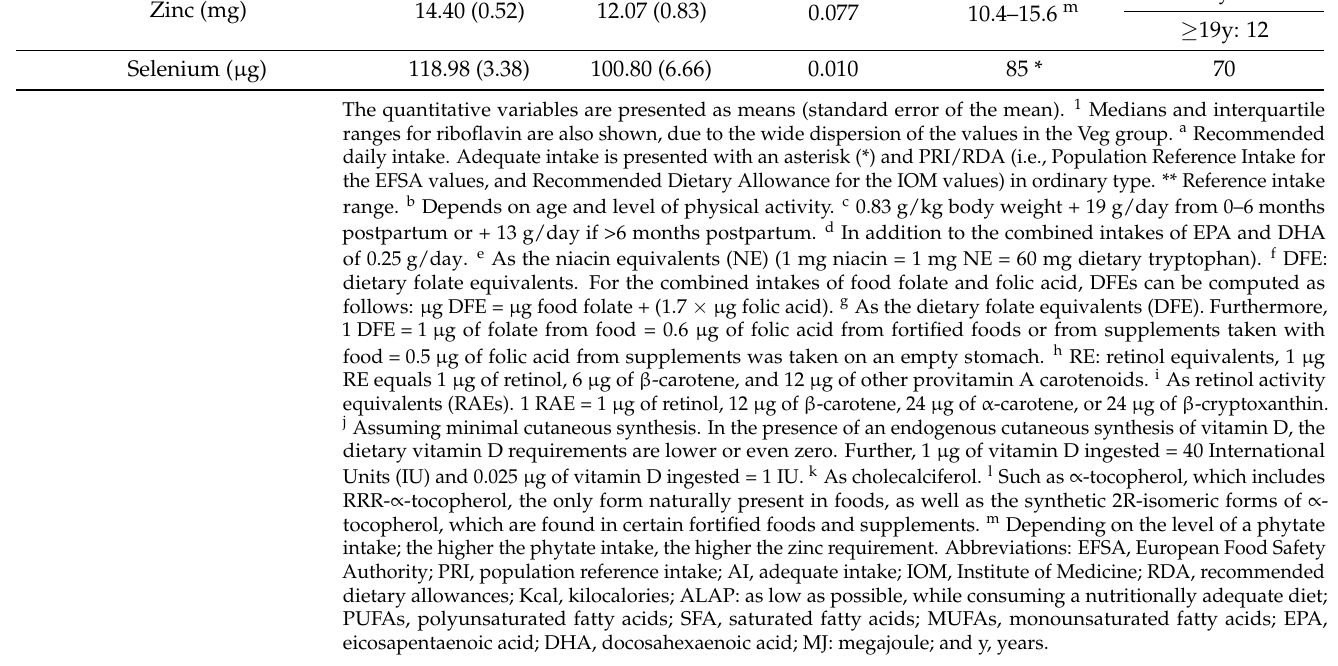
Table 6. Prevalence of inadequate intakes of specific nutrients in omnivore human milk donors